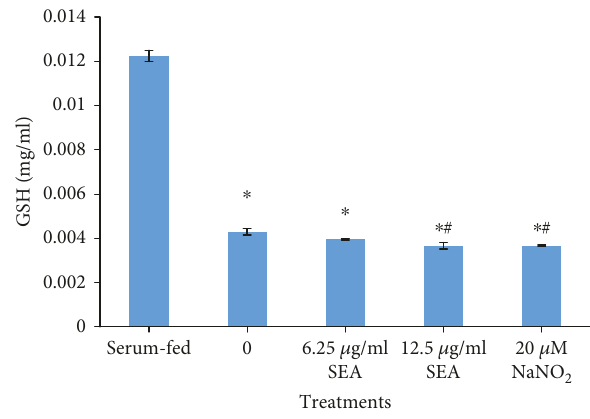
Figure 2: schSEA depletes GSH levels in prostate (PNT2) cells. Statistical signi fi cance by Student ’ s t -test; ∗ p ≤ 0 05 (serum-fed vs. serum-starved experiments) and # p ≤ 0 05 (non-schSEA -treated cells). Results treatment vs. schSEA-treated cells/NaNO 2 are representative of three independent experiments. Table 1: E ff ect of SEA treatment on proliferation of PNT2 cells. schSEA ( μ g/ml)